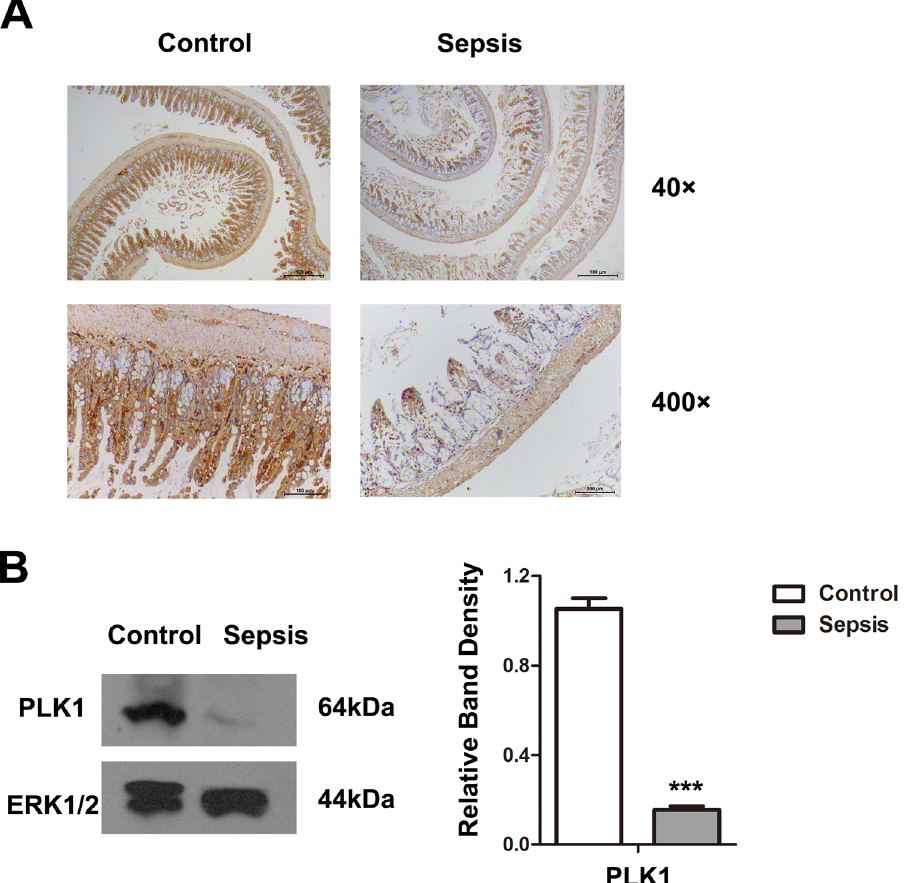
Figure 3. Sepsis induces PLK1 down-regulation in intestinal epithelium. ( A ) Immunohistochemical staining for PLK1 in intestinal tissue sections of control and septic animals. ( B ) Western blot analysis of PLK1 in intestinal tissue of control and septic mice. ERK1/2 was used as control. The graph represents the relative band densities. Values are mean ± SEM (n = 3). *** P 0.001 versus control